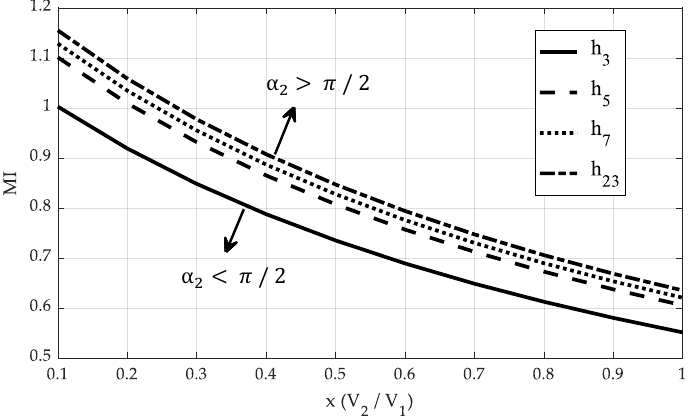
Figure 10. Relationship among MI, x, and the removed harmonic order at the edge additive/subtractive of the DC sources.